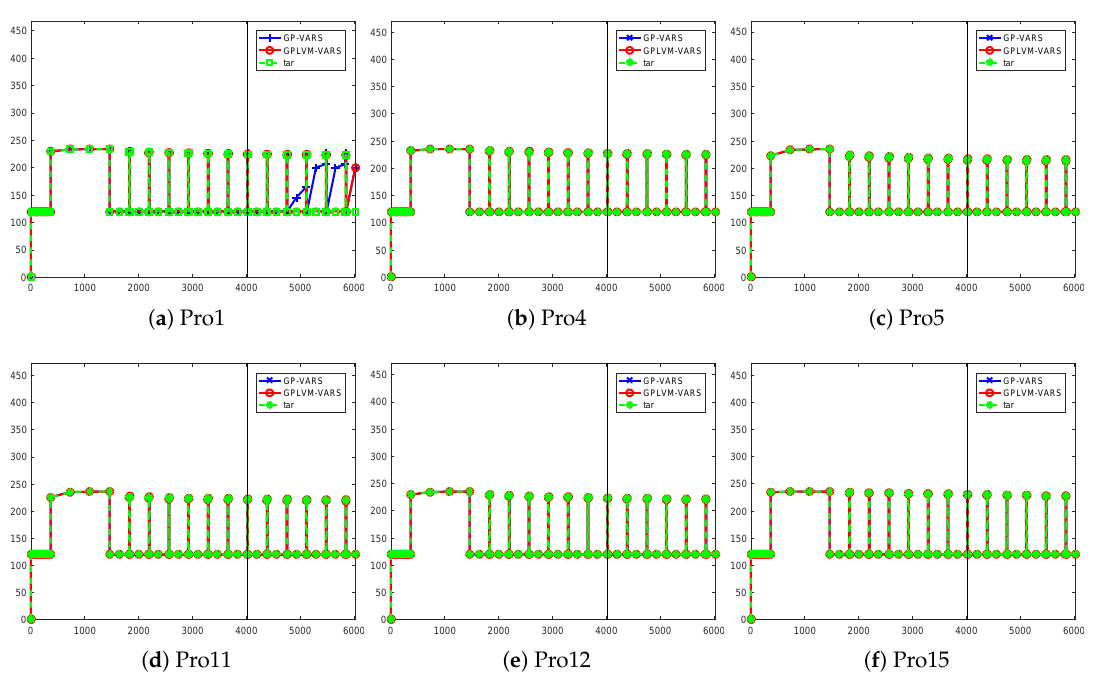
Figure 10. Comparison of WBHP with 4000 training and 2000 testing data for six wells (the black vertical line indicating present